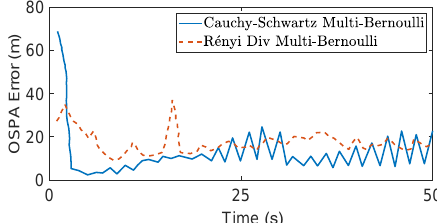
Figure 11. OSPA errors returned by the sensor control method based on Cauchy–Schwarz divergence [35] compared to the Rényi divergence-based sensor control [11], as reported in [35].